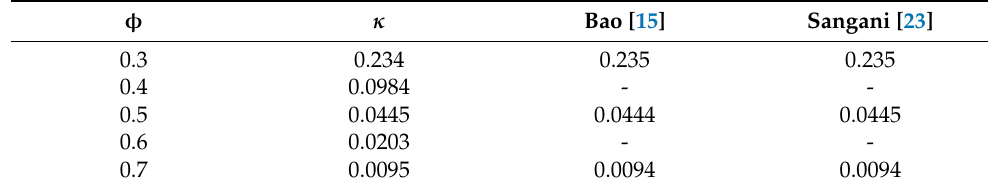
Table 2. Variation of axial Darcy permeability with ɸ for square configuration.